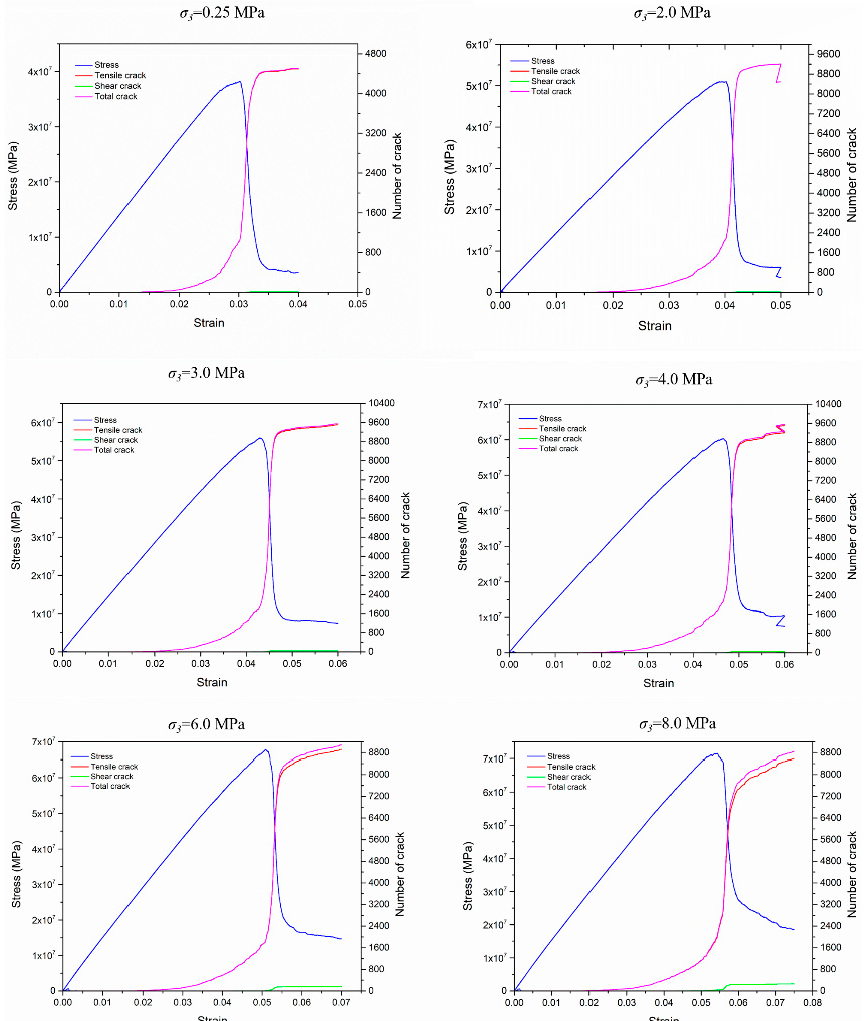
Figure 17. The development and number of tensile and shear cracks during the increase of confining stresses.